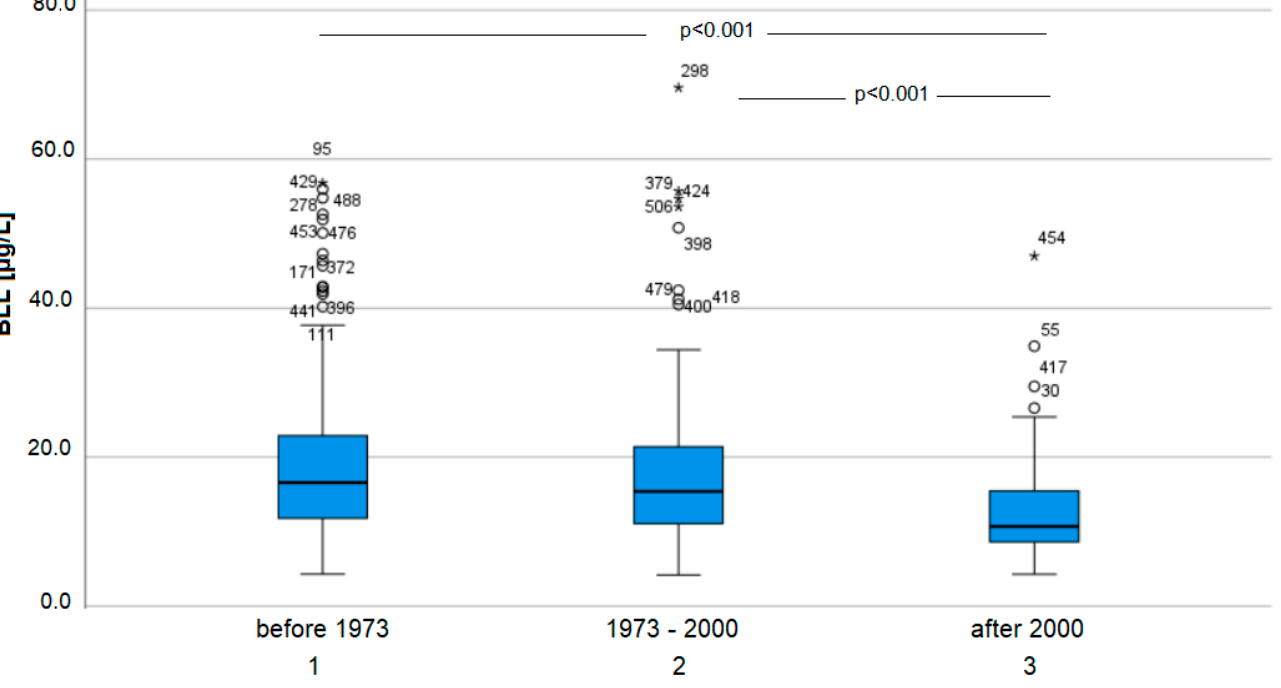
Figure 5. BLL and age of real estate p = 0.043. Outliers marked with * are values above the third quartile plus 1.5 times the interquartile range.